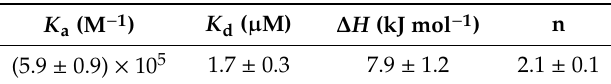
Table 1. List of the best-fitted values for the binding energetics parameters between the Singlet Oxygen Chemiluminescence probe (SOCL) and bovine serum albumin (BSA), as determined by isothermal titration calorimetry